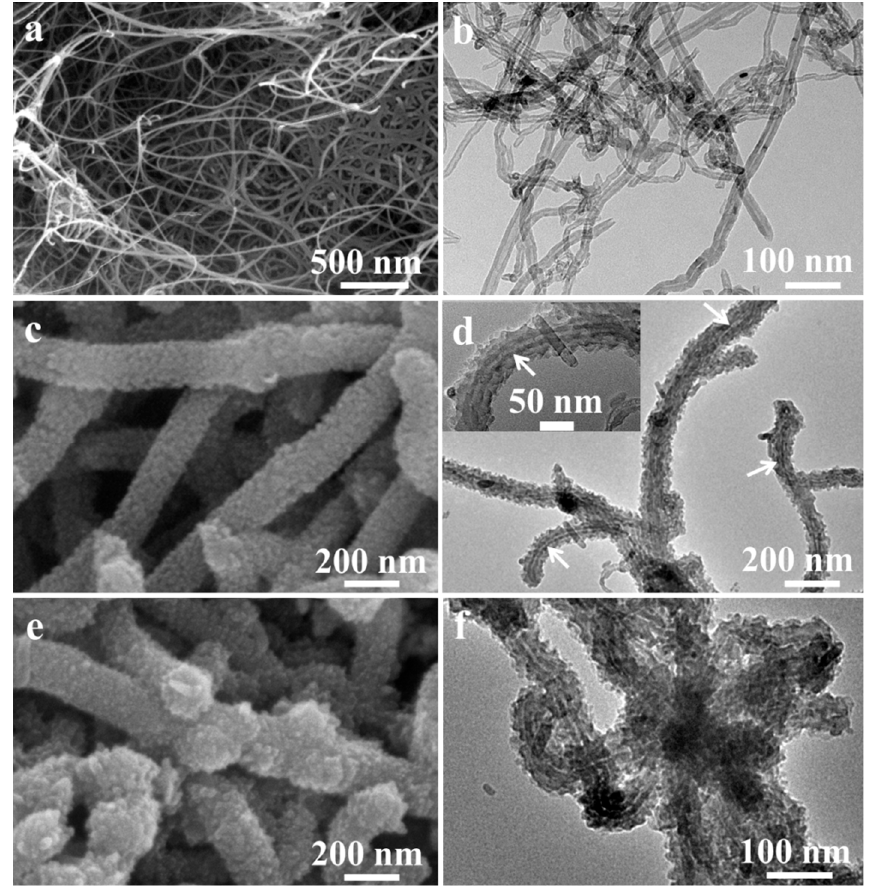
Figure 2. ( a ) SEM, ( b ) TEM image of MWCNTs; ( c ) SEM, ( d ) TEM image of p-PANI/CNT fibers, Inset: Magnified TEM image of p-PANI/CNT fibers; ( e ) SEM, ( f ) TEM image of n-PANI/CNT fibers.